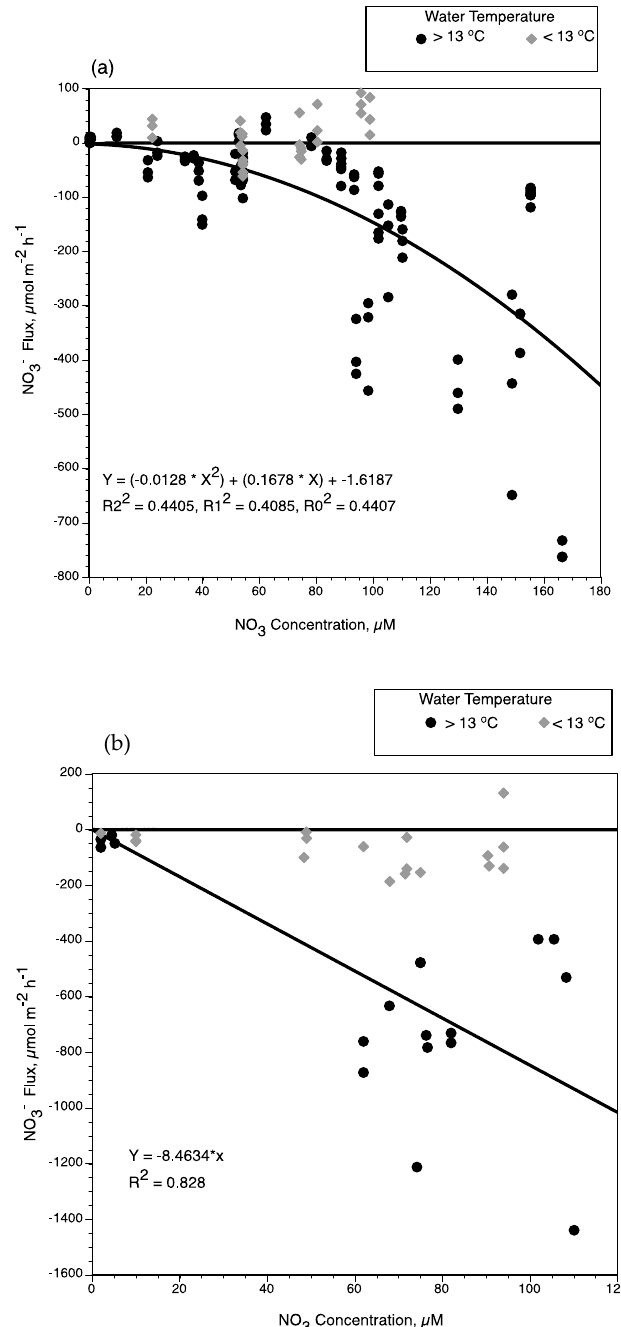
Figure 9. ( a ) Rate of nitrate uptake ( μ mol m − 2 h − 1 ) versus nitrate concentration for all the subtidal sediment experiments with grouping by water temperature >13 °C (black circles) and <13 °C (grey diamonds). The polynomial curve fit is only for concentration and rates measured at temperatures >13 °C. ( b ) Rate of nitrate uptake ( μ mol m − 2 h − 1 ) versus nitrate concentration for intertidal sediment experiments in this study and in [25] and [56] with grouping by water temperature >13 °C and sediment organic matter > 5% (black circles); compared to <13 °C and sediment organic matter <5% (grey diamonds). The linear curve fit is only for concentration and rates of the black circles.